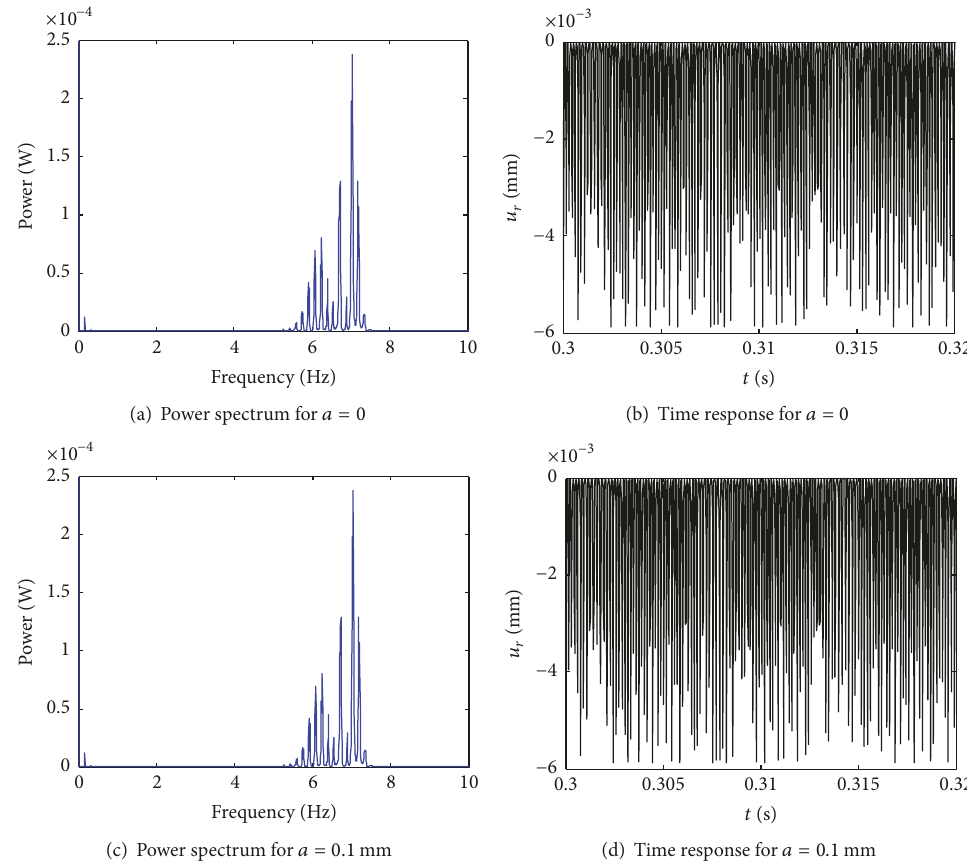
Figure 18: Power spectrum and time response of rotor for different wave generator